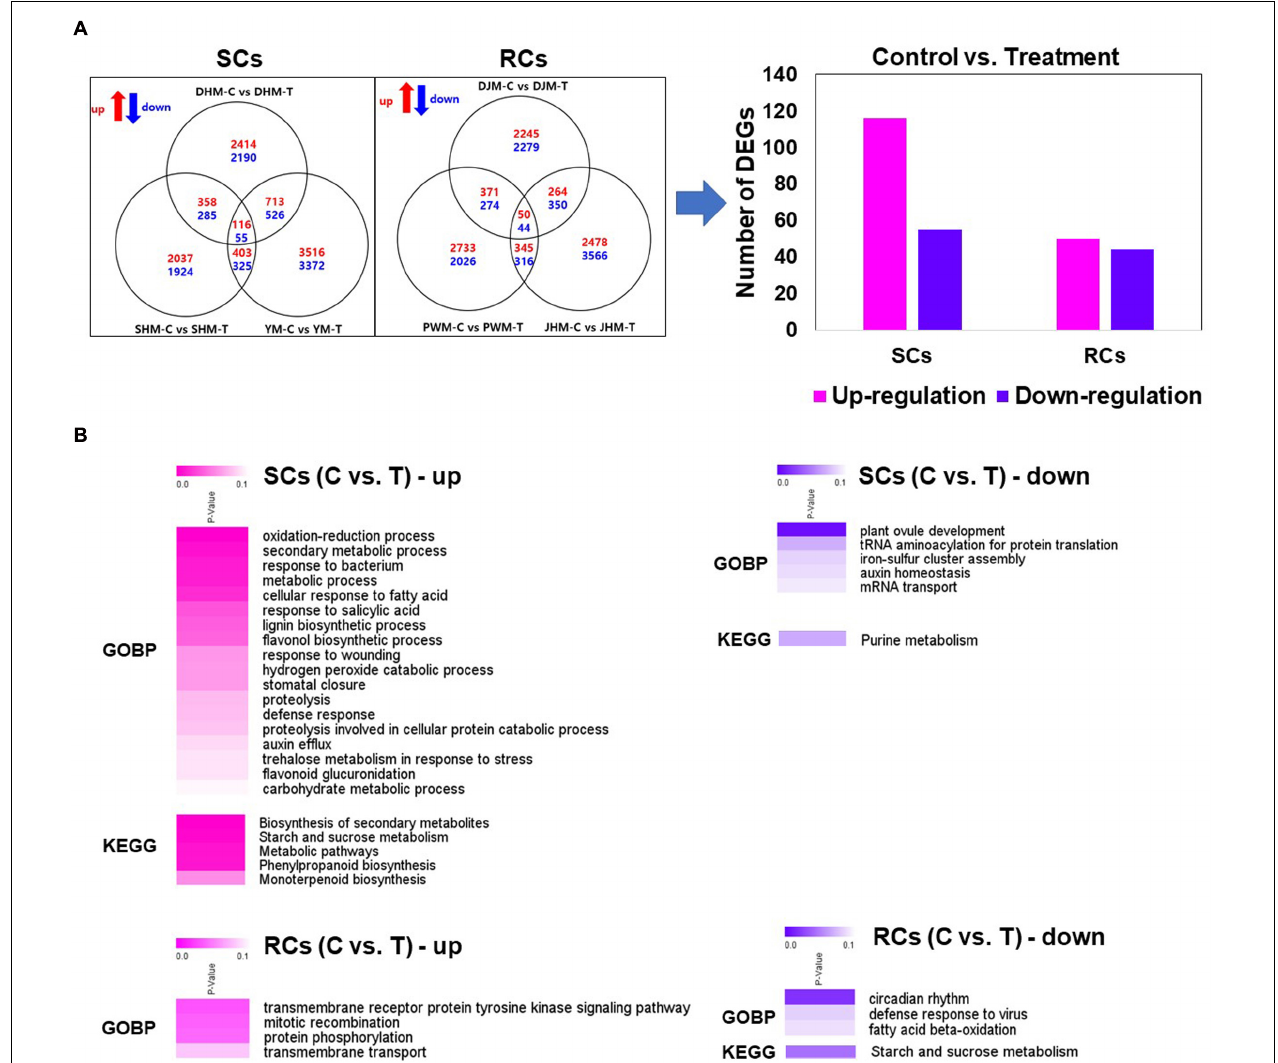
FIGURE 3 | Identification of DEGs in pairwise comparisons across samples, and heatmap of Gene Ontology (GO) biological process category and Kyoto Encyclopedia of Genes and Genomes (KEGG) pathways enriched in the induced defense response. (A) Venn diagrams showing the number of DEGs with up- or downregulated expression in the pairwise sample comparisons. (B) Heatmap of GO biological process category and KEGG pathway of DEGs in pairwise sample comparisons between control (C) and treatment (T). The heatmap shows Benjamini–Hochberg-adjusted ( P < 0.05) for DEGs enriched in specific GO terms in